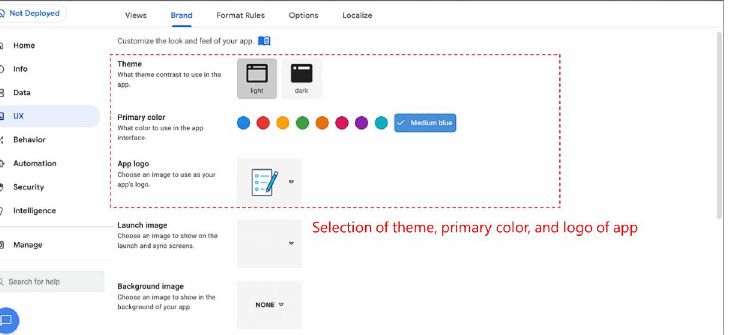
Figure 19. Screen image for design of app color and logo